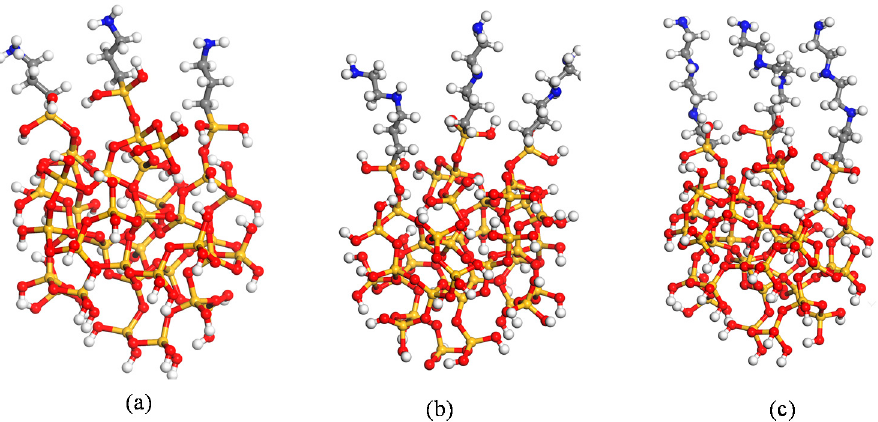
Figure 3. ( a ) A1100 aminosilane coupling agents grafted on the surface of nanoparticles; ( b ) A1120 aminosilane coupling agents grafted on the surface of nanoparticles; ( c ) A1130 aminosilane coupling agents grafted on the surface of nanoparticles.